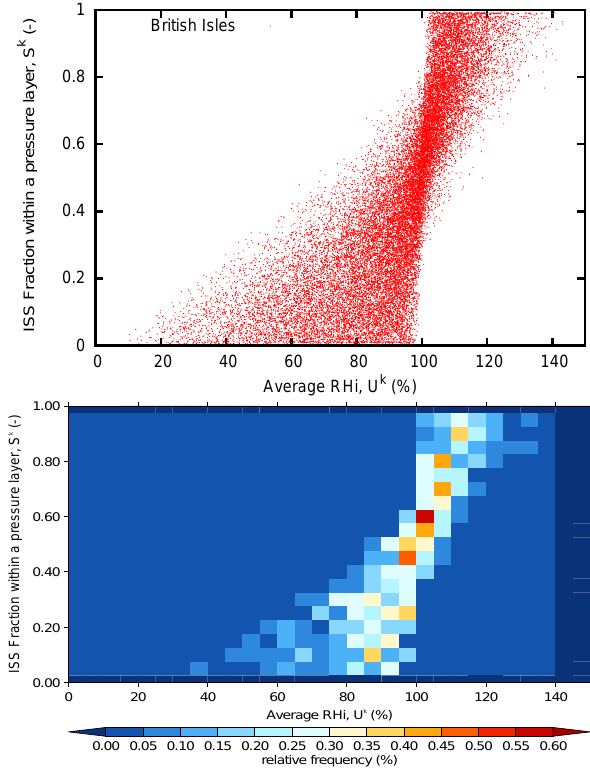
Fig. 4. Relationship between the average RHi ( U k in %) and ISS fraction ( S k ) within 50hPa layers (400–150hPa). These data are derived from five years of UK Met Office high resolution radiosonde launches from Camborne, Castor Bay, Herstmonceux, Albemarle, Lerwick and Watnall launch stations (January 2002 – December 2006). Panel (a) shows each individual 50 hPa pressure layer from the full dataset. Panel (b) shows a contour plot of the probability distribution of the full dataset, for clarity (in the contour plot only) data from pressure layers of an ISS fraction=0 (zero ice supersaturation) and an ISS fraction=1 (fully ice supersaturated) were removed.